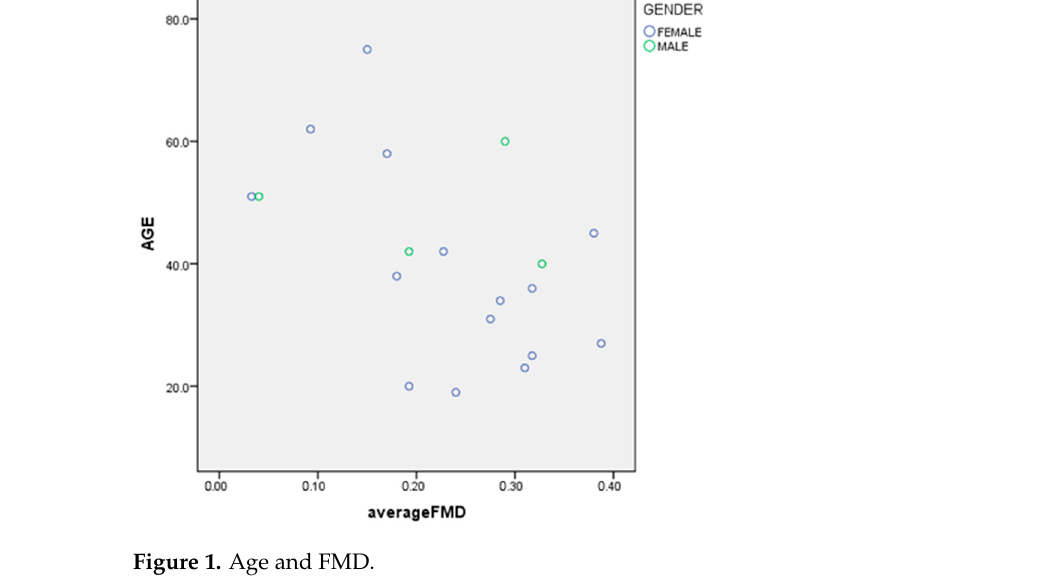
Figure 1. Age and FMD. Correlation Coefficient − 0.496 Correlation Coefficient − 0.496 Significance p = 0.031 Significance p =